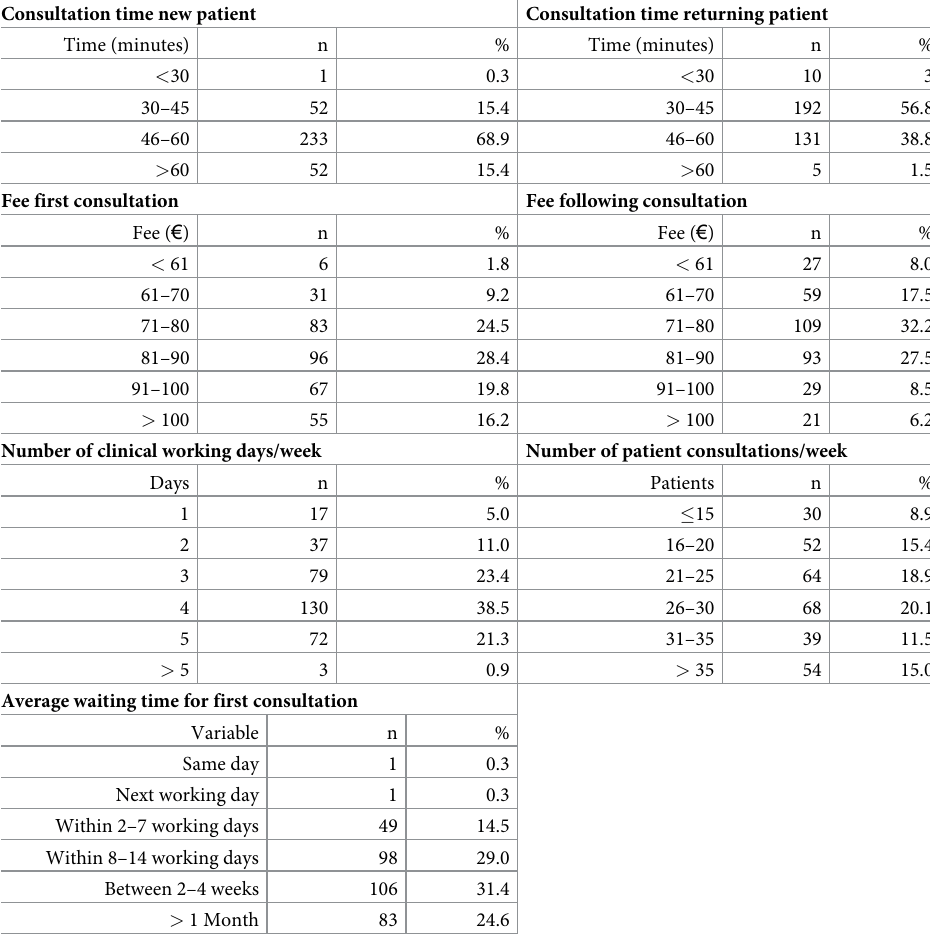
Table 3. Main practice characteristics of respondents (n = 338).